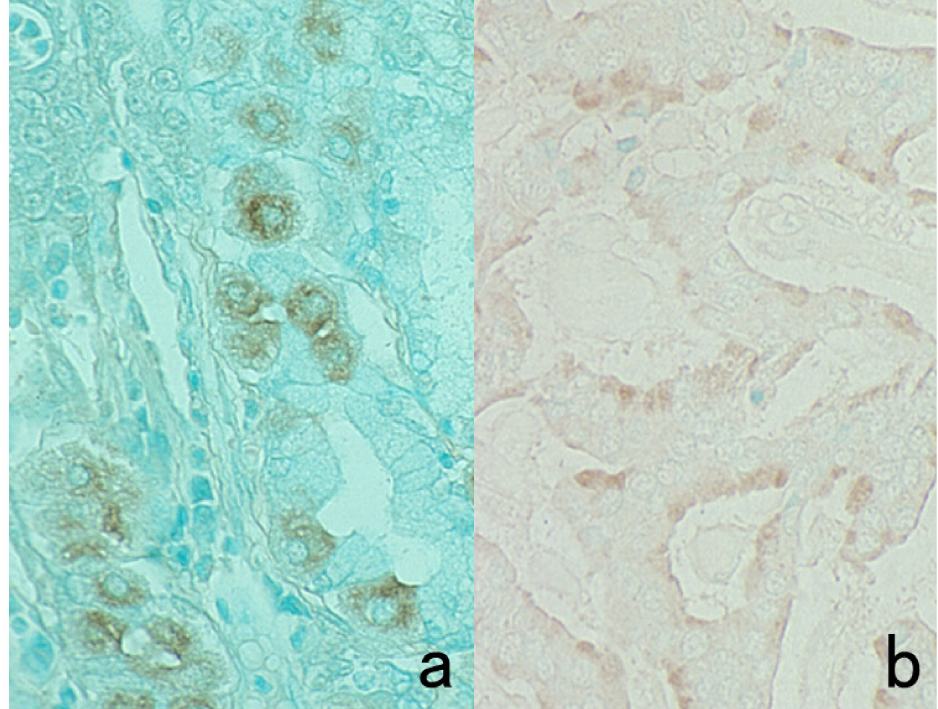
Figure 54. Nonspecific binding of IgG in certain cells in FFPE sections. ( a ): Glicentin (enteroglucagon equivalent) immunoreactivity in gastric parietal cells and ( b ): motilin immunoreactivity in rectal carcinoid tumor. Certain cells may adsorb the antibody molecules nonspecifically, causing false- positive immunostaining. The nuclei are counterstained with methyl